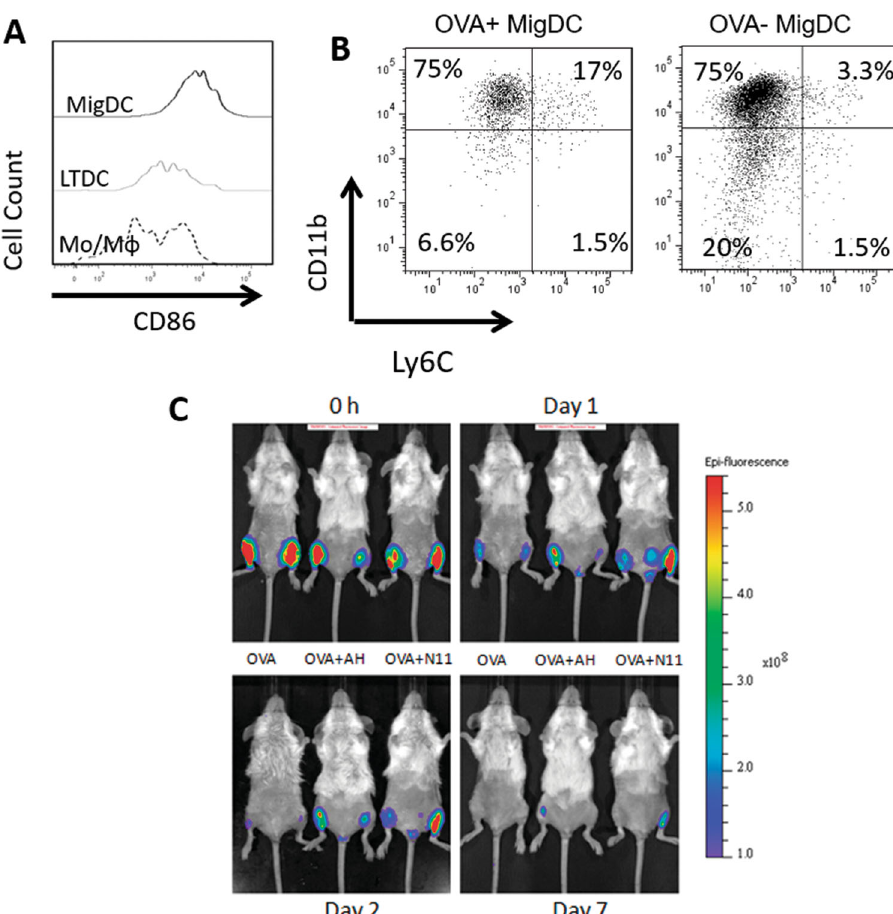
draining lymph node. Lymph nodes were harvested 2 days after injection of 10 μ g Alexa Fluor 647-labeled OVA adjuvanted with 200 μ g Nano- 11 and data are representative of two independent experiments. c Mice were injected with 10 μ g of Alexa Fluor 647-conjugated OVA alone